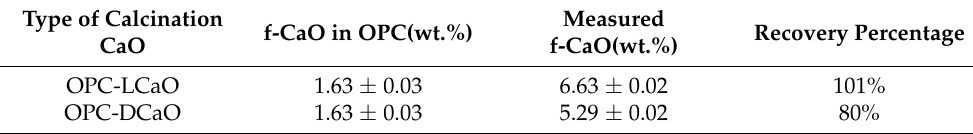
Table 3. Effect of different types of calcination CaO on measured f-CaO content (under ASTM C114-18). Type of Calcination f-CaO in